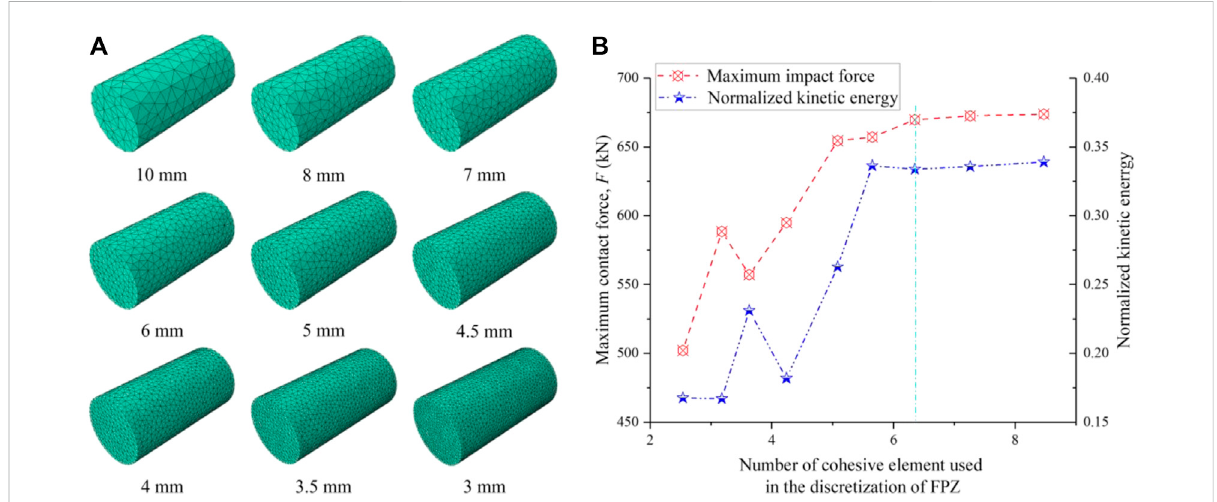
FIGURE 4 (A) Nine models meshed with different element sizes; (B) Variations in the maximum impact force and normalized kinetic energy against the number of cohesive elements (the mesh size of the right of the green vertical dashed line can achieve the simulation accuracy and computational cost).